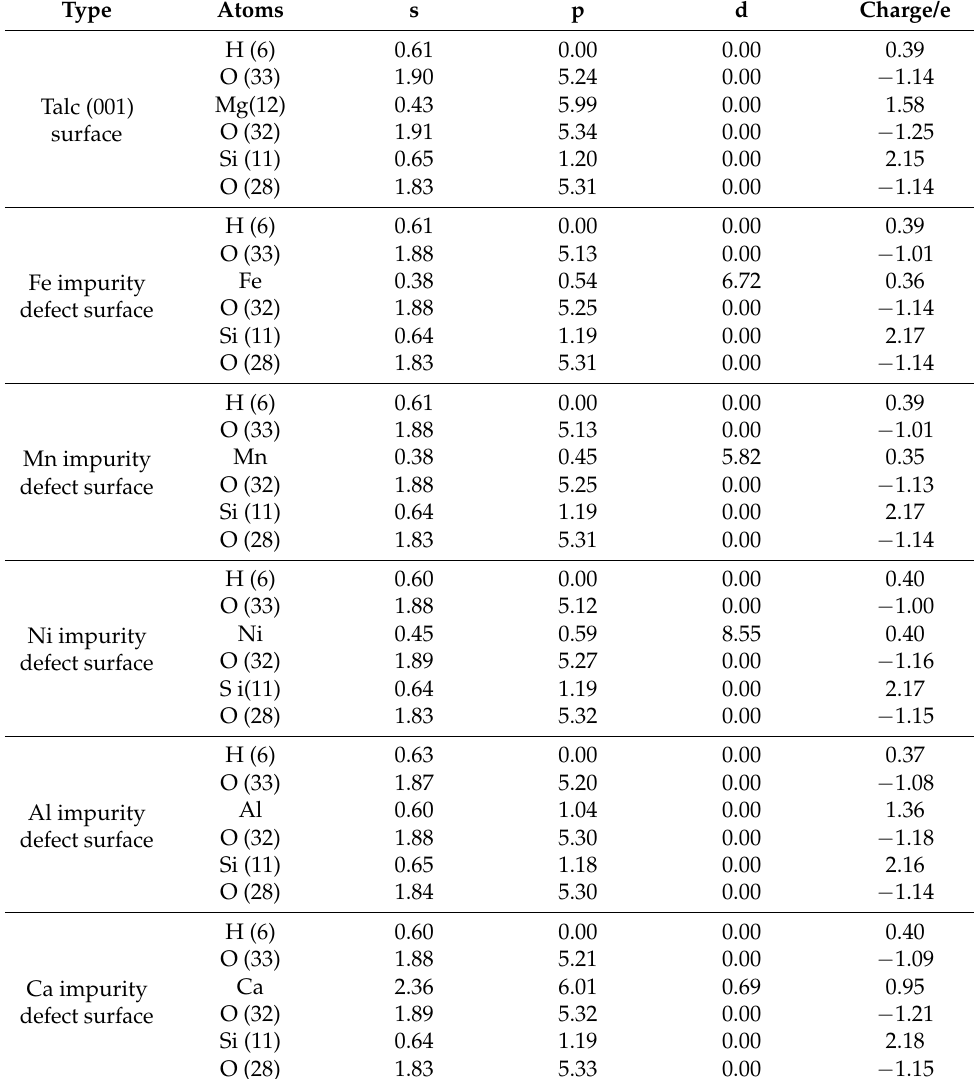
Table 3. Mulliken population analysis of adjacent atoms with impurity